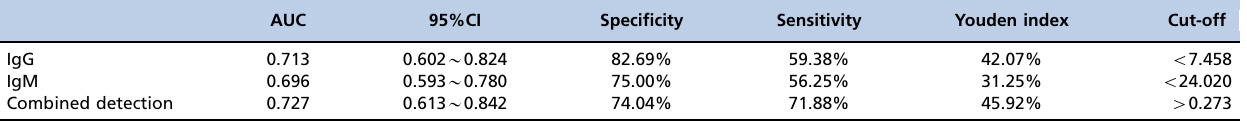
Table 6 - Receiver operating characteristic